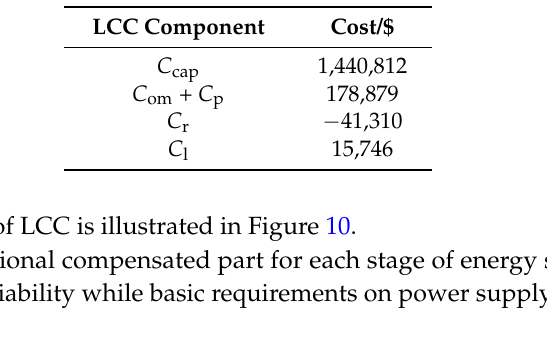
Table 10. Calculation results of each LCC